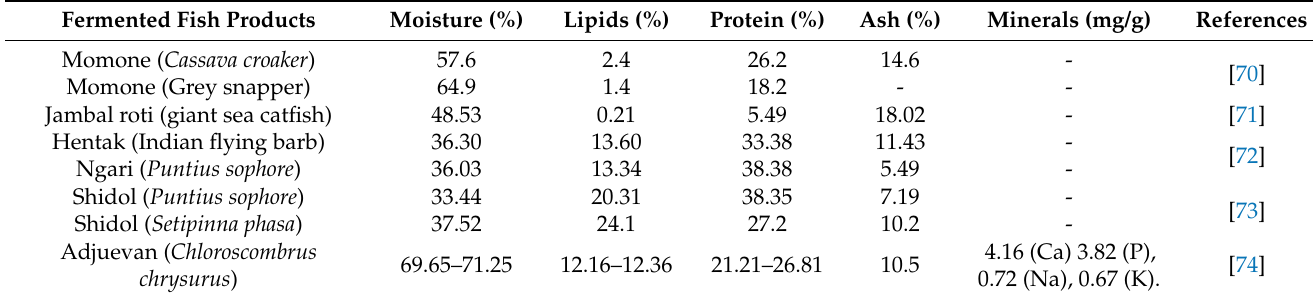
Table 2. Fermented fish products and their respective proximate